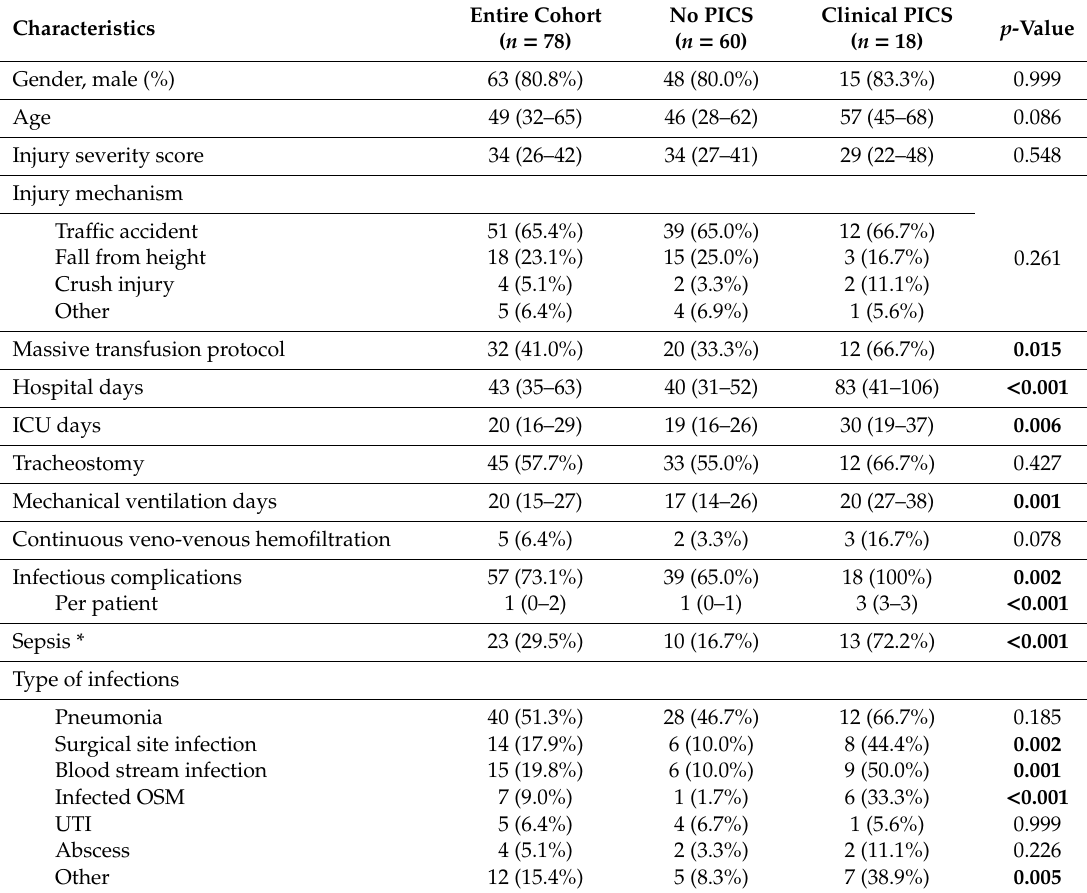
Table 1. Patient characteristics of clinically identified PICS patients vs. other CCI patients.